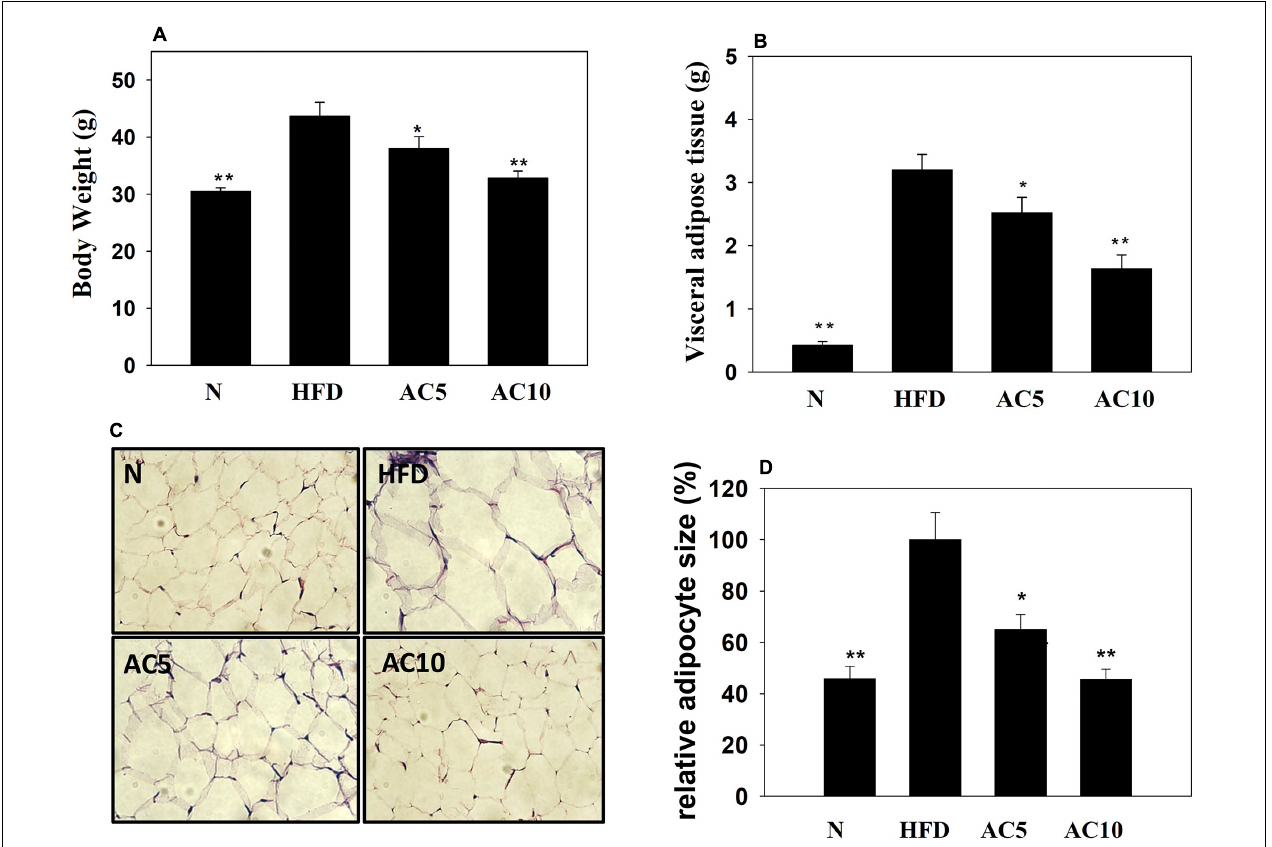
FIGURE 7 | Acacetin (AC) (5 or 10 mg/kg) decreased the body weight (A) and the visceral adipocyte tissue weight (B) of HFD-induced obese mice. (C) Histological sections of visceral adipocyte tissue in mice. (D) Adipocyte size in control HFD-induced mice compared to acacetin-treated HFD-induced obese mice. Data are presented as means ± SD, n = 8. ∗ P < 0.05, ∗∗ P < 0.01 compared with HFD-induced obese